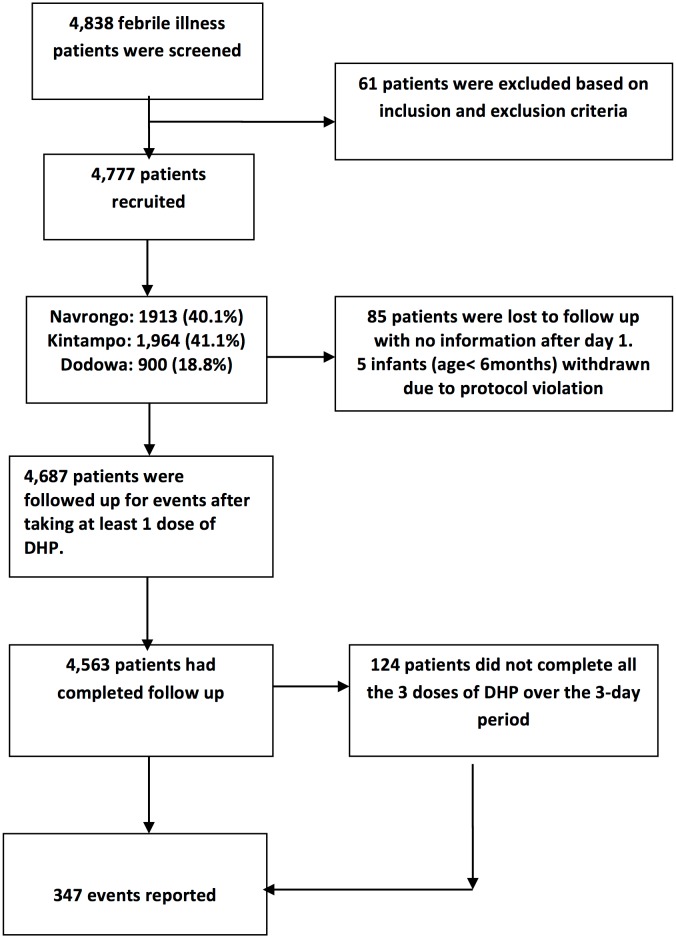
The geographical location of the three health and demographic surveillance sites in Ghana where the study was conducted.This figure is for illustrative purposes only.